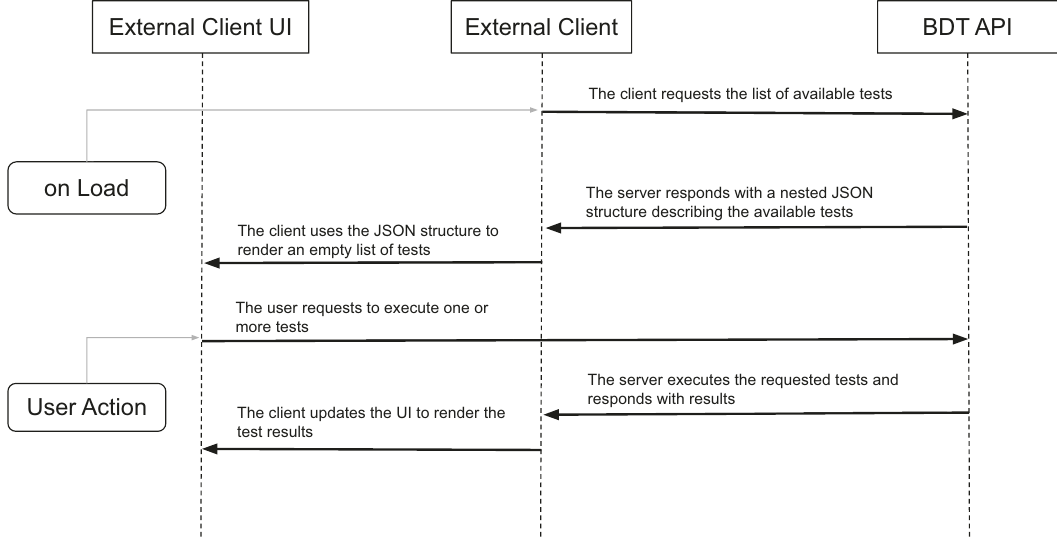
Fig. 6 Substitutable FHIR Bulk Data testing. The open-source Bulk Data Tester API can be loaded through a web-based client for rendering available tests, allowing a customizable user